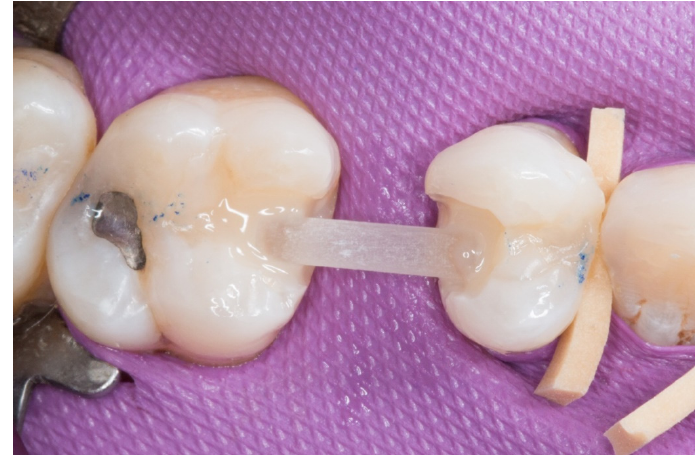
Figure 4. The horizontal fiberglass pin bonding to the adjacent teeth.